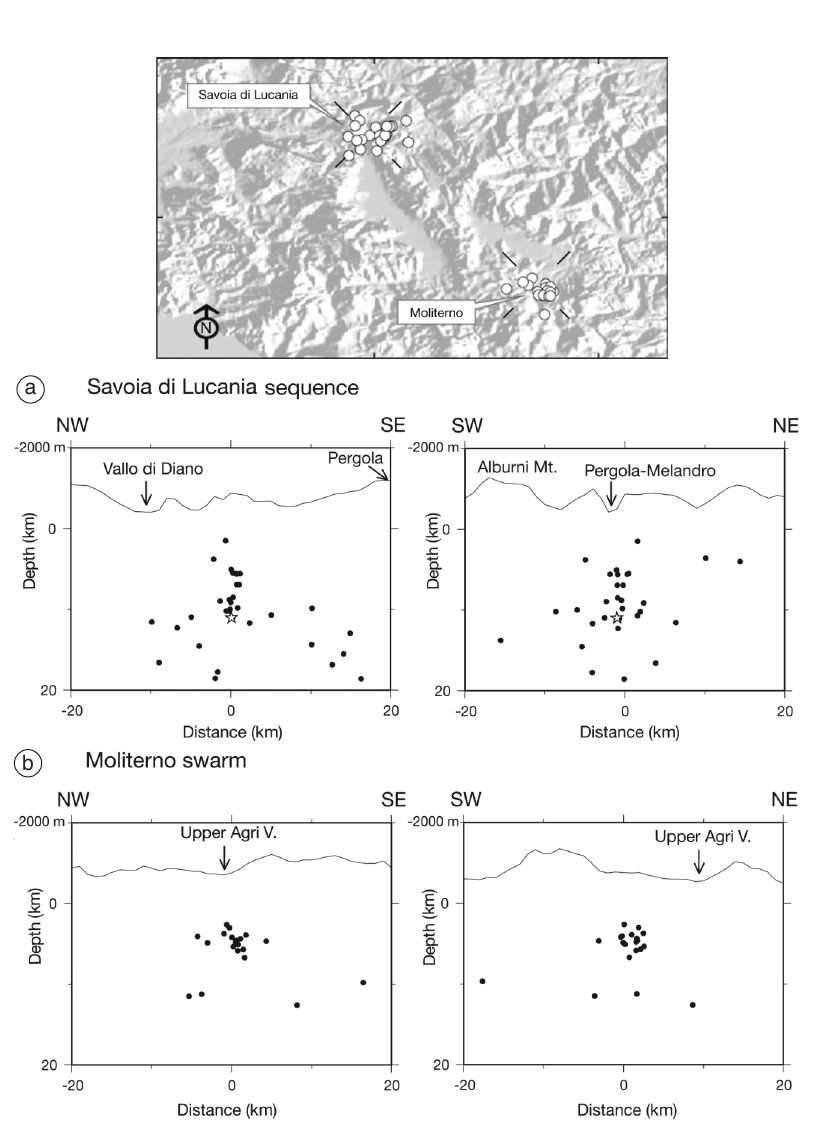
Fig. 5a,b. Epicentral locations and depth distribution of the a) Savoia di Lucania and b) Moliterno seismic se- quences. Star indicates the mainshock hypocenter of the Savoia di Lucania sequence. Topography is vertically